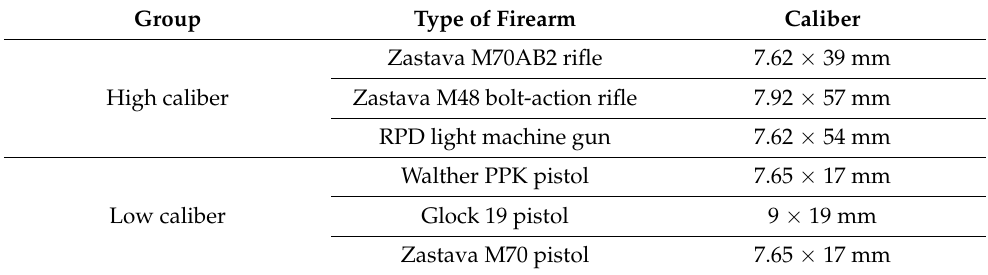
Table 1. Types of firearms used in the test.